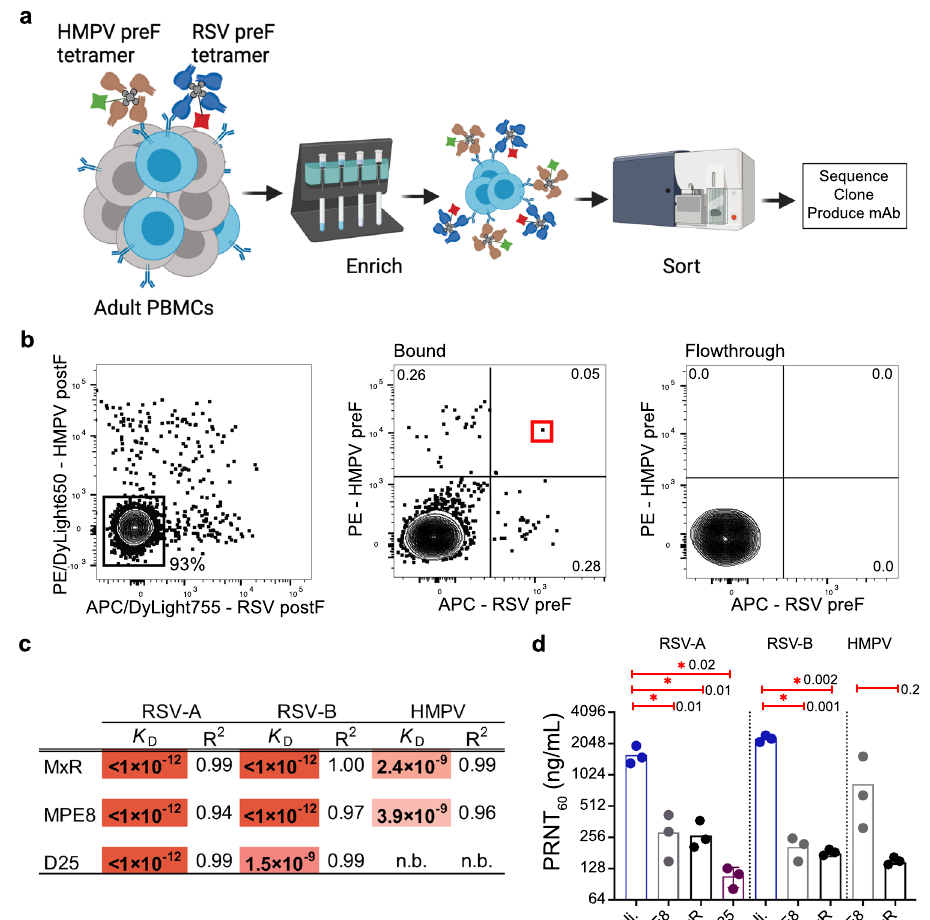
Fig.3|Identi fi cationandanalysisofHMPV/RSVcross-neutralizingmonoclonal antibodies.a RSV-andHMPV-bindingBcellsfromhumanblood werelabeled with APC-conjugated streptavidin tetramers of biotinylated RSV prefusion protein (preF)andPE-conjugatedstreptavidintetramersofbiotinylatedHMPVpreF. b Flow cytometry plot of RSV and HMPV preF-binding B cells after gating for live, CD3 − CD14 − CD16 − CD19 + CD20 + (B cells), IgD − /IgM − (isotype-switched), and APC/ Dylight755 - HMPVpostF − andPE/Dylight650 − RSVpostF − (toexcludecellsbindingto RSV/HMPV postF, APC, PE, or streptavidin). The bound fraction contains magne- tically enrichedcells using APC- and PE-speci fi c microbeads. Numbers on plots